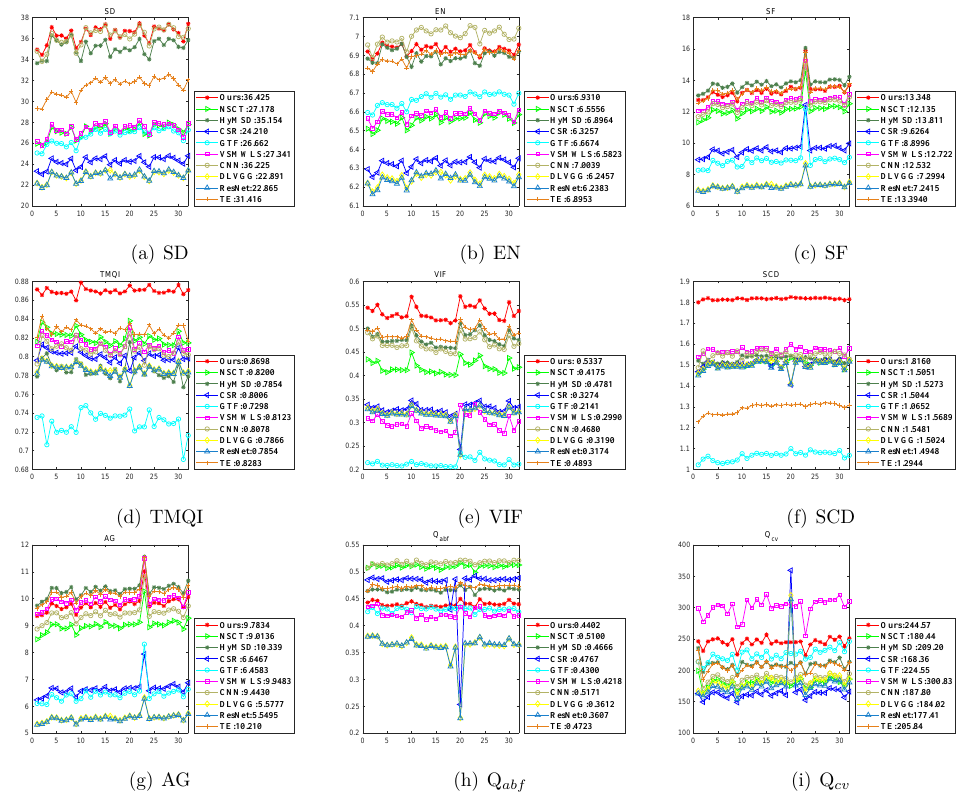
Figure 11. Quantitative comparisons of the nine metrics using nine representative methods on the Nato-camp sequence. For all methods, the average values are shown in the legend. ( a ) SD, ( b ) EN, ( c ) SF, ( d ) TMQI, ( e ) VIF, ( f ) SCD, ( g ) AG, ( h ) Q abf , ( i ) Q cv